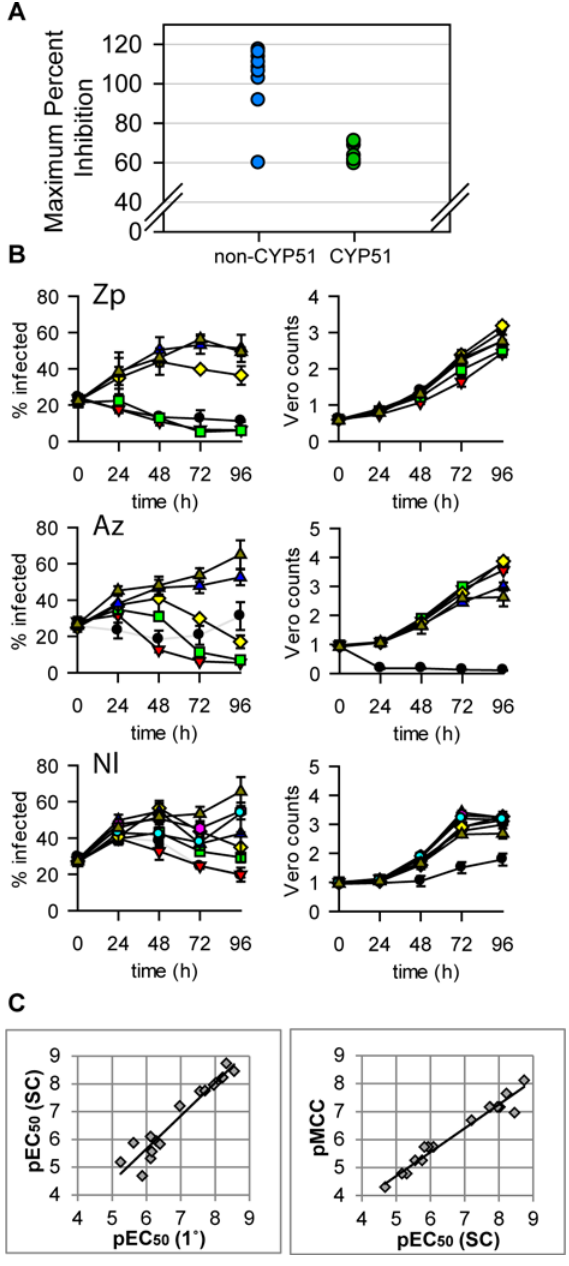
Fig 8. Static-cidal results for hits from the screen. Panel A. Maximum percent inhibition seen in static- cidal assay relative to Nifurtimox at t = 96h (100%) and t = 0h (0%). The data-set is split in half; the CYP51 inhibitors are marked in green, the other compounds in blue. Panel B. Static-cidal profiles for 3 of the hits: Ziprasidone (Zp), Azelastine (Az) and Nilotinib (Nl). Infection curves at concentrations that were toxic to the host cells are shown in light grey instead of black. Concentrations are as follows ( μ M): black circle 50, red triangle 17, green square 5.6, yellow diamond 1.9, blue triangle 0.6, pink hexagon 0.2, cyan circle 0.07, triangle dark yellow 0. Panel C. Left panel: scatterplot comparing the potencies obtained in the primary screening assay (x-axis) with the potencies obtained in the static-cidal assay (y-axis). A linear regression was fitted to the data (R 2 = 0.92). Right panel: scatterplot comparing the potencies obtained in the static-cidal assay (x-axis) with the minimum cidal concentration (y-axis) obtained in the rate-of-kill assay. A linear regression was fitted to the data (R 2 = 0.96). Panel